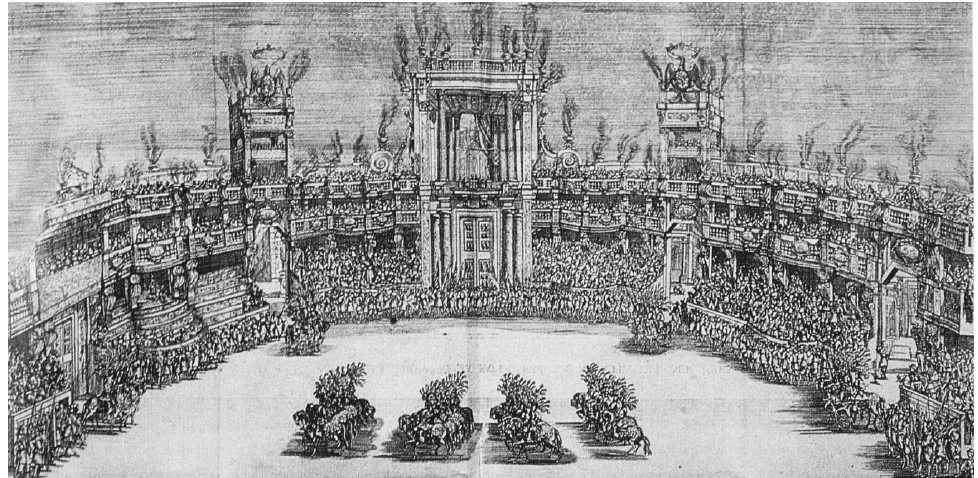
Figure 13. Theater of the tournament for the Liberazione tentata da Venere . Bologna 20 March 1628. Source: G.B. Coriolanus in Fagiolo M. (ed.), Le capitali della Festa. Italia centrale e meridionale, Roma, Italia [20].